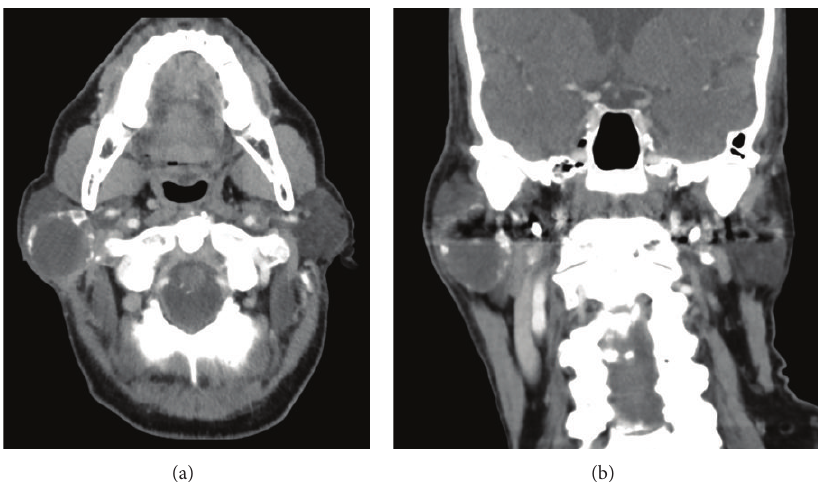
Figure 1: Computed tomography scan. (a) Axial and (b) coronal sections demonstrating a well-circumscribed, solid, isodense 4 × 3.5 cm mass with rim of peripheral calcification.